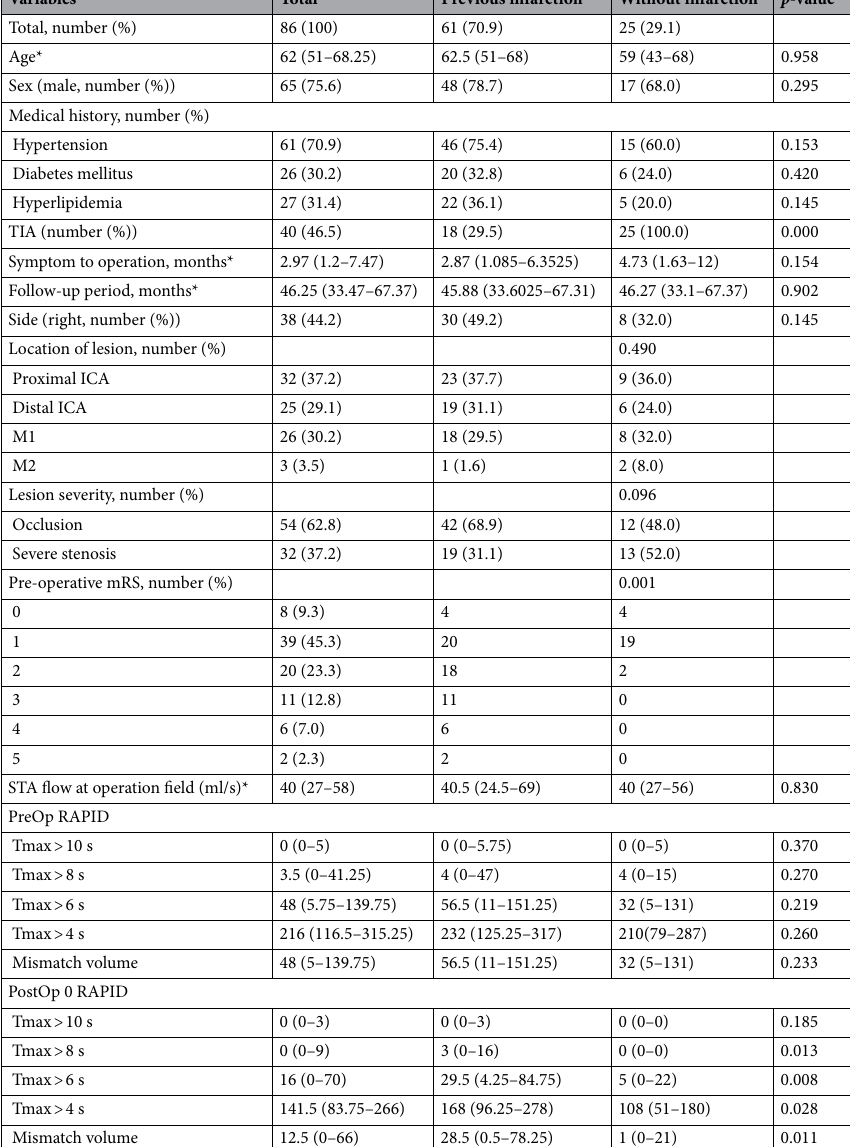
Table 1. Patient characteristics. TIA, transient ischemic attack; ICA, internal carotid artery; mRS, modified Rankin Scale; STA, superficial temporal artery; PreOp, pre-operative; PostOp 0, immediate post-operative. *Median